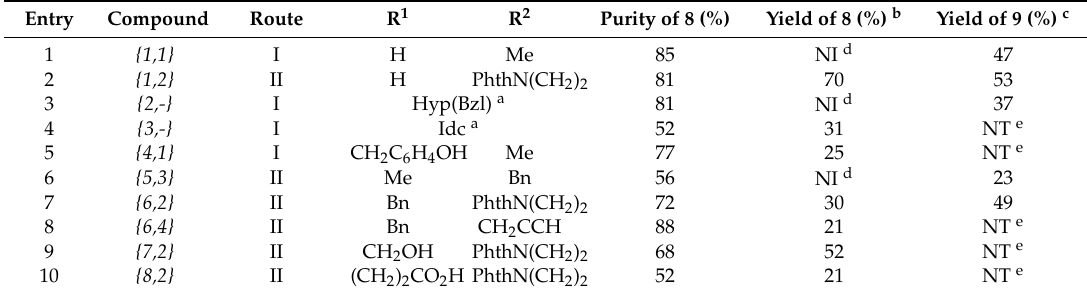
Table 1. List of prepared compounds 8 and 9